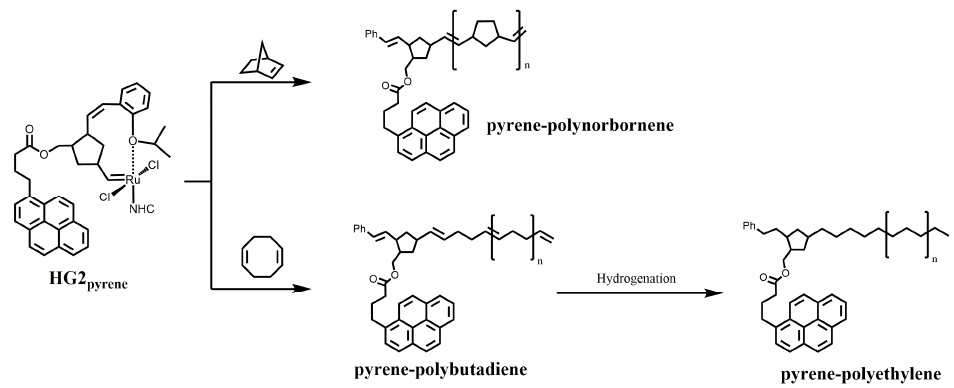
Figure 3. Synthesis of polymers having chain with a pyrene terminal.